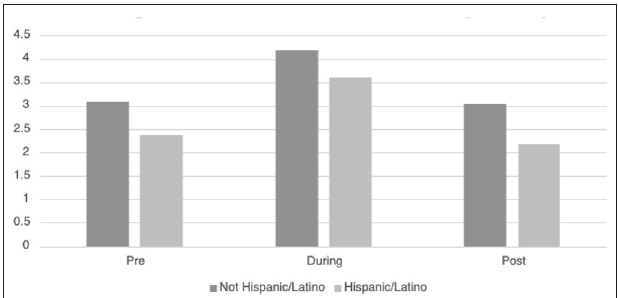
FIGURE 3 | Differences in HRVi Minimum by ethnicity. Children who were not Hispanic/Latino had higher HRVi Minimum at every time point compared to children who were Hispanic/Latino ( F (2, 93) = 5.27, p = 0.024, η 2 p =